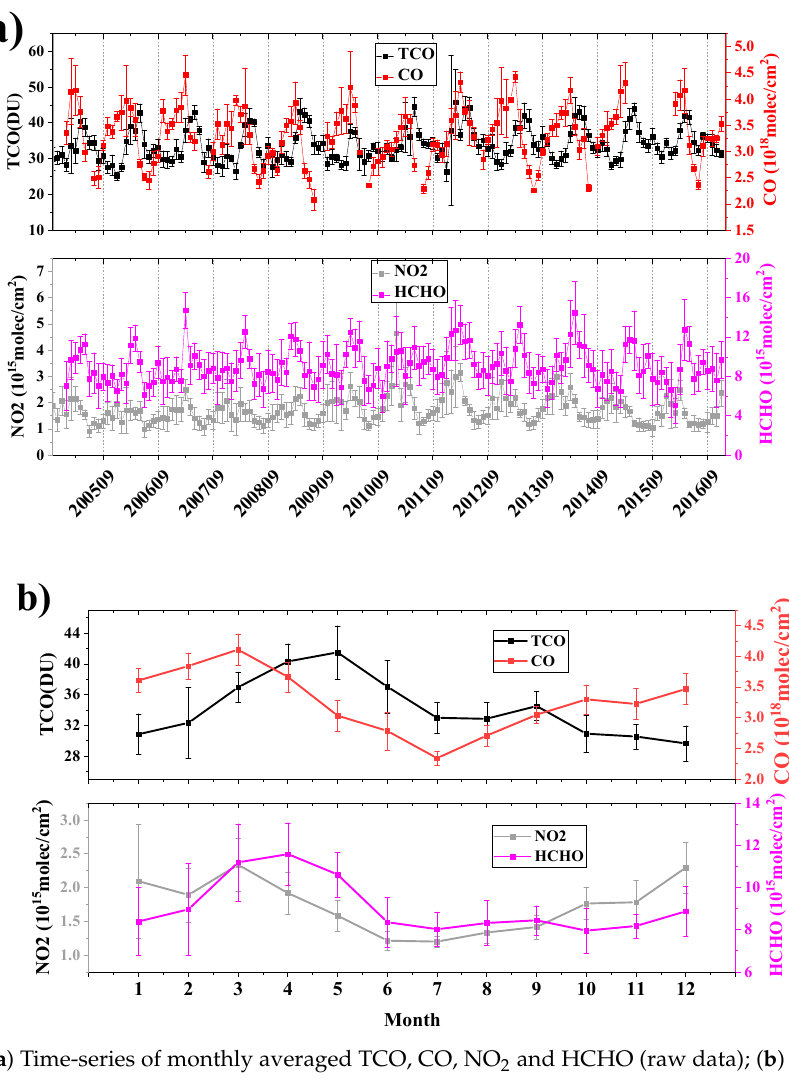
Figure 2. ( a ) Time-series of monthly averaged TCO, CO, NO 2 and HCHO (raw data); ( b ) Multiyear monthly averaged TCO, CO, NO 2 and HCHO (based on the raw data present in ( a )). Vertical bars indicate one standard deviation.